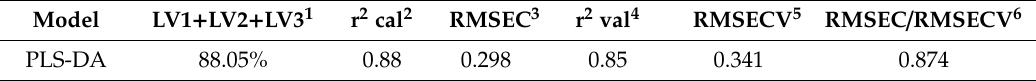
Table 2. Parameters from partial least squares-discriminant analysis (PLS-DA) classification model of UPLC-HRMS data from cashew apple pulps of different genotypes.